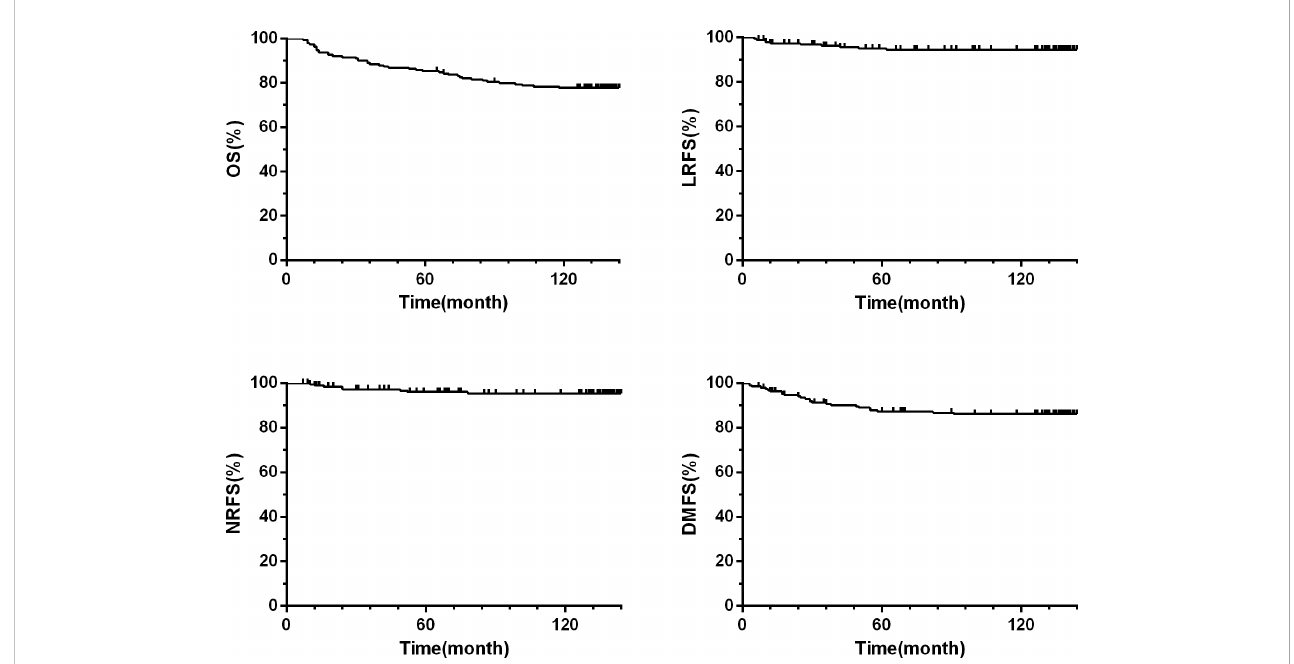
FIGURE 1 Kaplan-Meier estimate of local relapse-free survival (LRFS), nodal relapse-free survival (NRFS), distant metastases-free survival (DMFS), and overall survival (OS) rates.